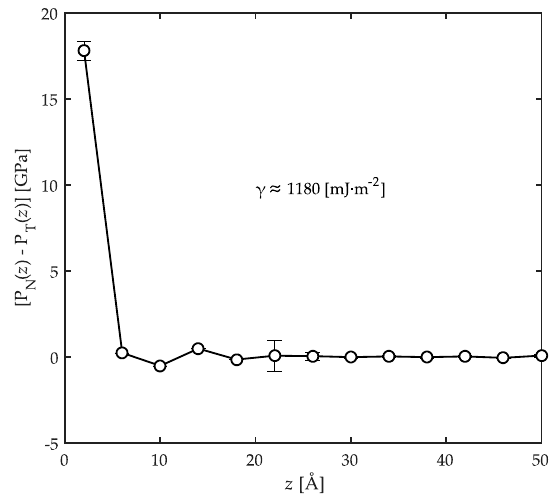
Figure 10. The profile of the difference of normal ( P N ( z )) and tangential pressures ( P T ( z )) across the film thickness for the confined PP/Fe 2 O 3 system at 458 K and 1 atm. The surface tension is calculated from Equation (6) to be approximately equal to ~1180 mJ·m − 2 .